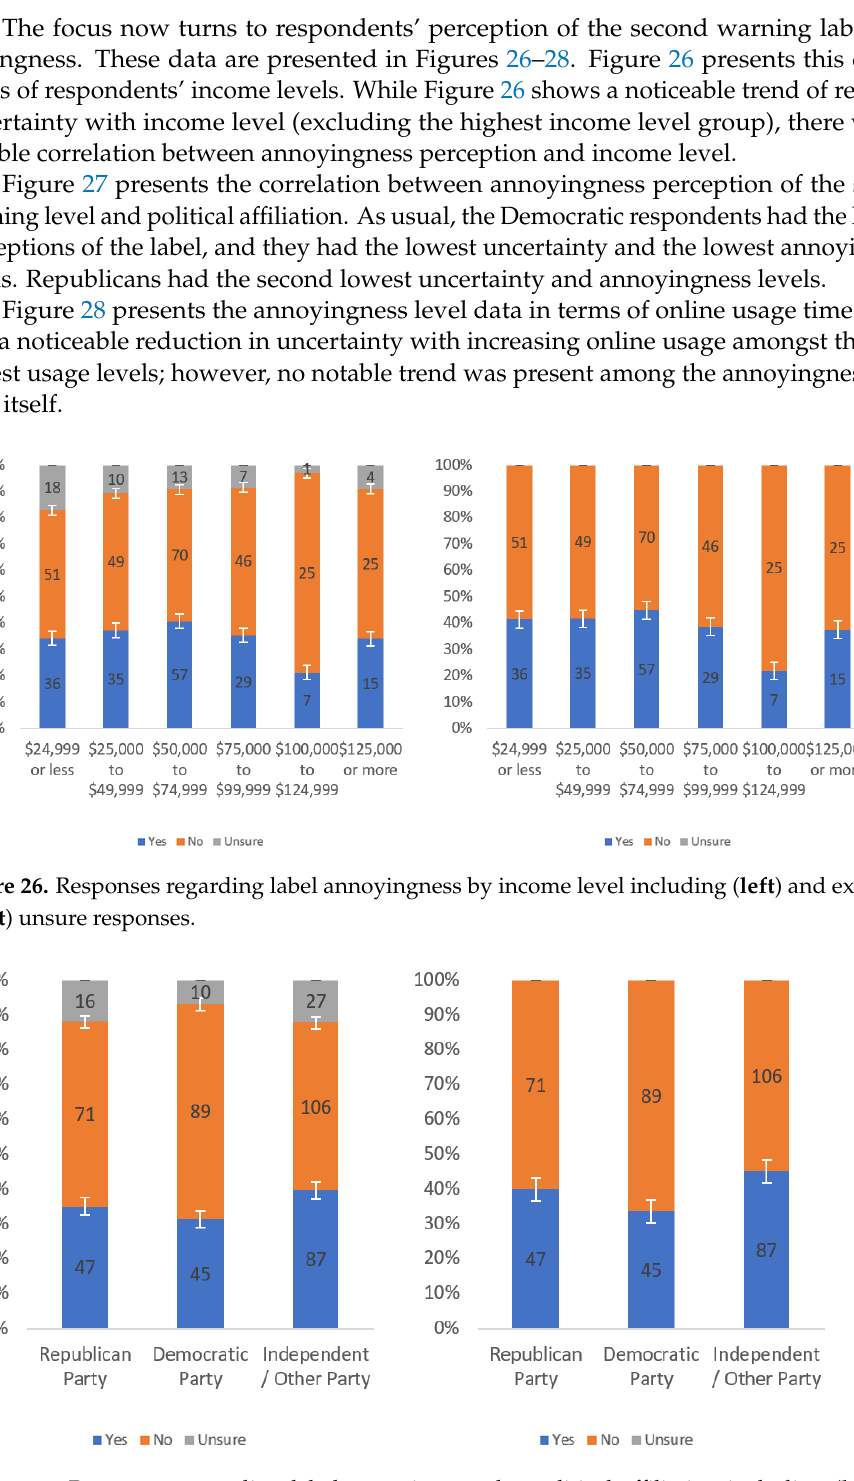
Figure 27. Responses regarding label annoyingness by political affiliation including ( left ) and excluding ( right ) unsure responses.